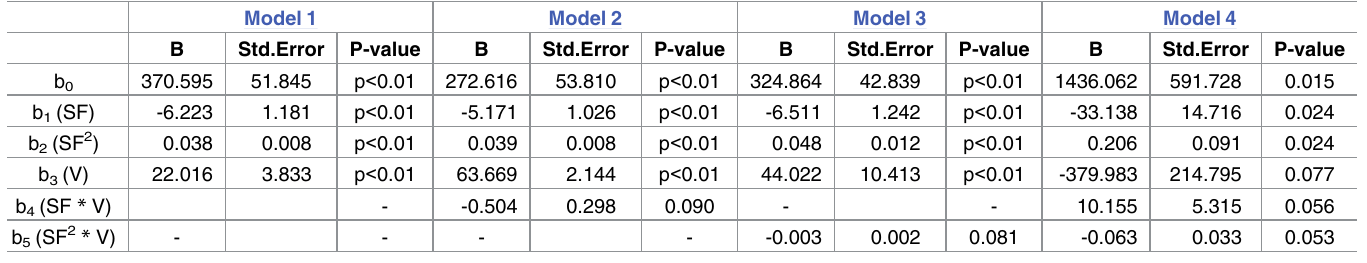
Table 1. Significance of the model